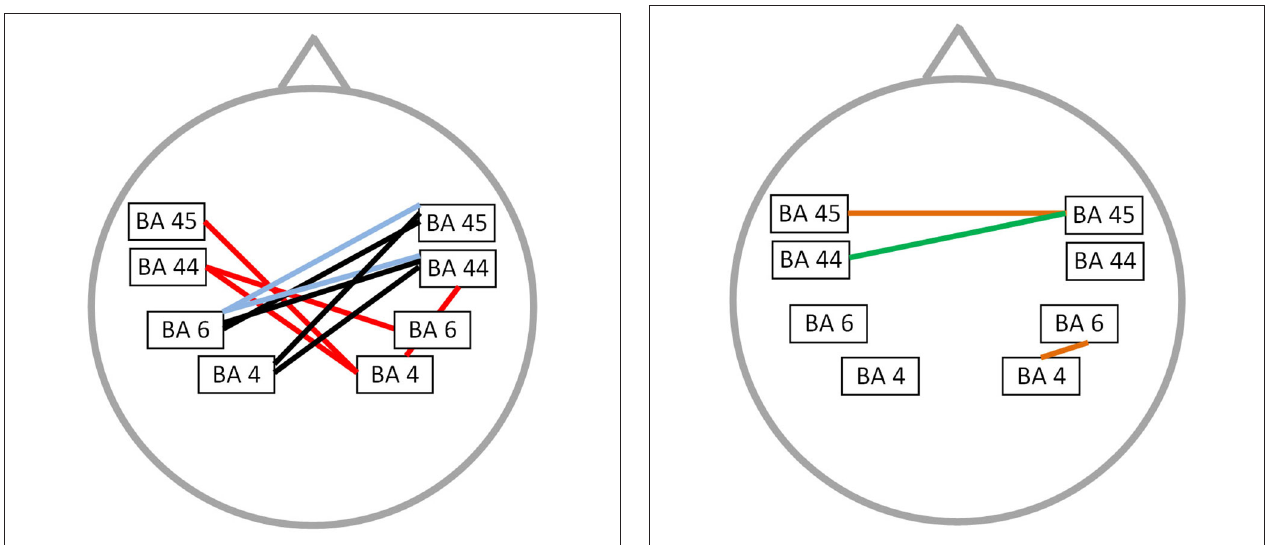
FIGURE 2 | Connectivity differences between PWS and fluently speaking controls . Decreased functional connectivity ( p < 0.01) in the beta 1 frequency band (red lines), beta 3 frequency band (bleu lines) and gamma frequency band (black lines) in stuttering patients vs. fluently speaking controls.